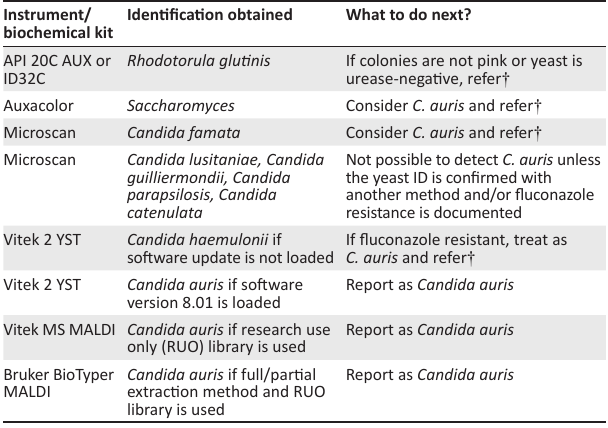
TABLE 1: When to suspect Candia auris in the clinical laboratory. 19 Instrument/ Identification biochemical kit